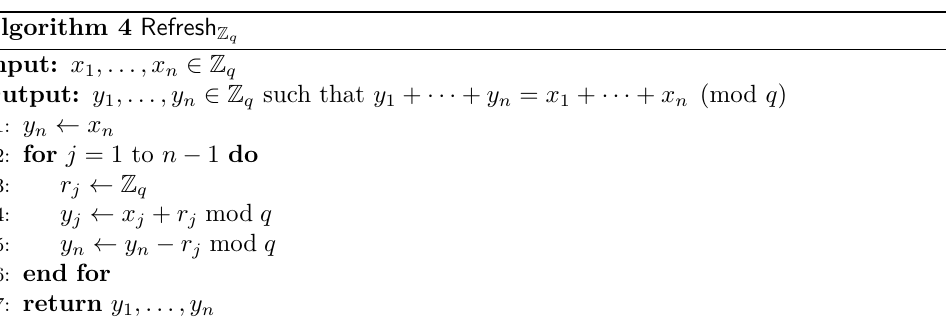
Algorithm 4 Refresh Z